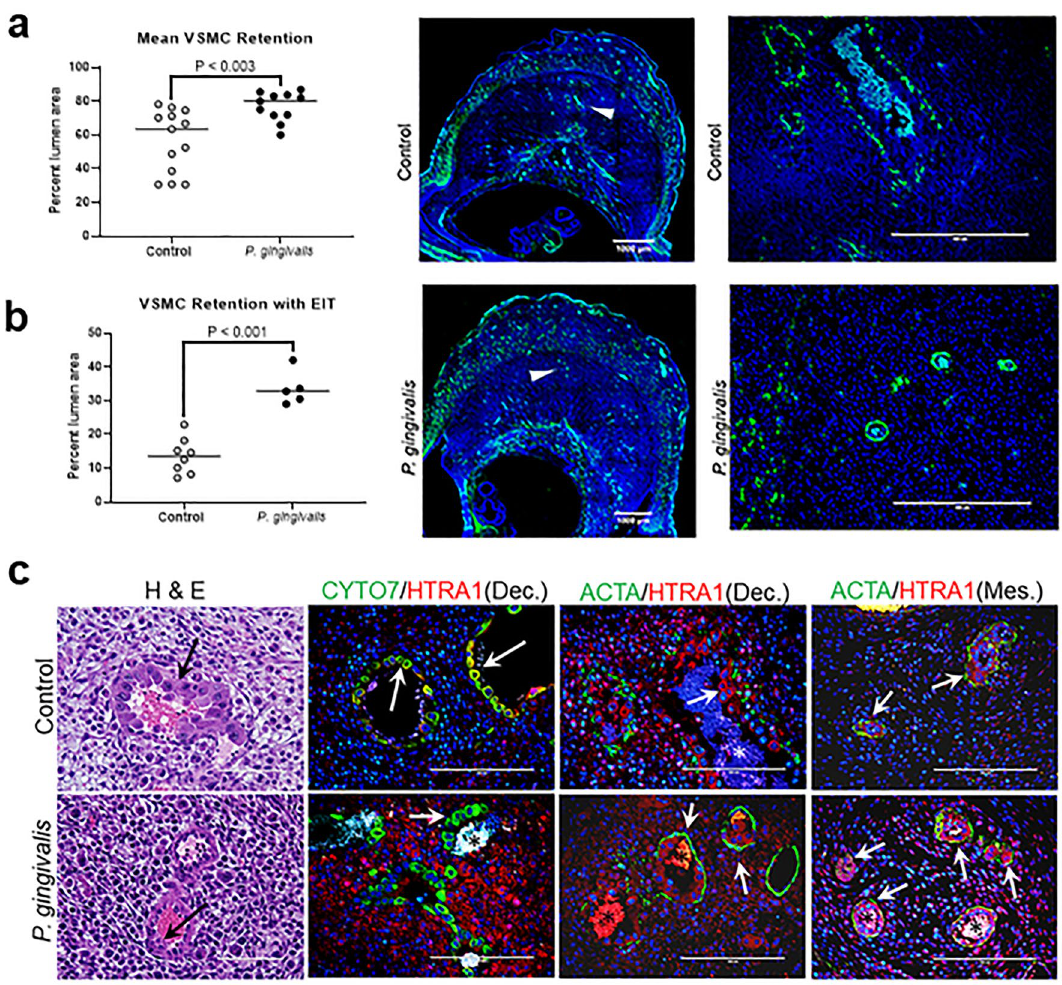
Figure 3. Retention of spiral arterial VSMC and invasive endovascular trophoblasts in GD11 specimens. ( a ) Mean percent circumferential area of spiral arterial VSMCs in specimens with and without endovascular invasive trophoblast (EIT). Each data point represents the average value of all area measurements taken within the middle portion of the utero-placenta. Horizontal bars are mean ± SD. Representative images of spiral arterial VSMC detected by staining for smooth muscle actin (ACTA, green) and DAPI staining for nuclei. Left panels are tiled composites of individual pictures taken at × 10 magnification with an EVOS Auto FL imaging system. Scale bar = 1000 µm. White arrowheads mark the spiral artery segments pictured in the corresponding right panels. White scale bar = 200 µm. ( b ) Mean percent circumferential area of VSMC in spiral arterial loops containing EIT. Horizontal lines = mean ± SD. ( c ) Representative images of EIT in hematoxylin and eosin stained sections (H&E), and by immunostaining with an antibody to cytokeratin 7(CYTO7, green) and high temperature requirement A1 (Htra1, red). Graphical data was analyzed by student’s t